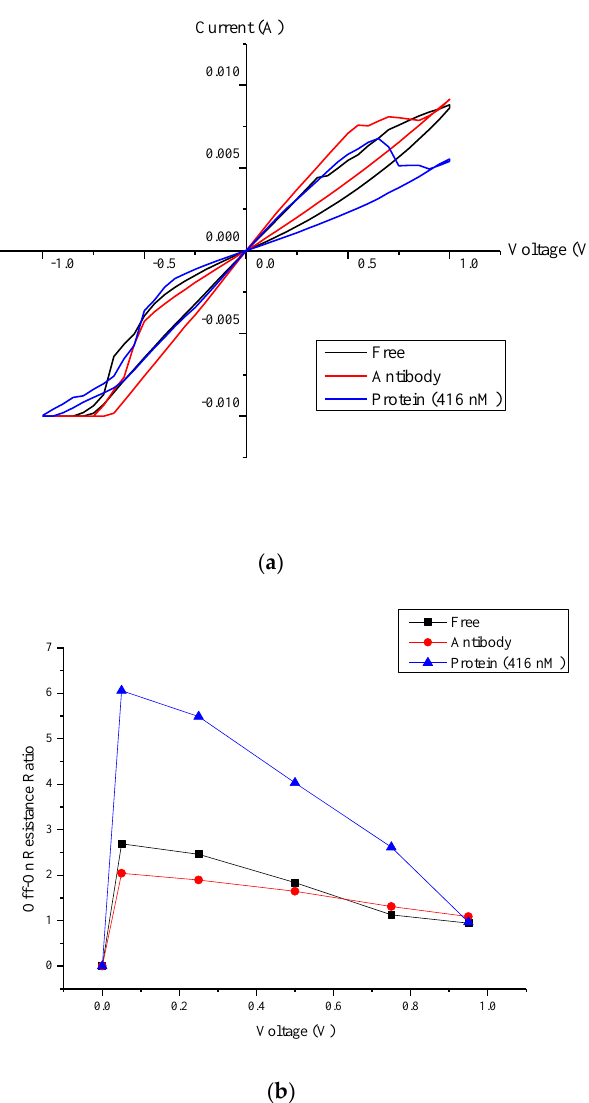
Figure 11. Characterisation plots; ( a ) I-V curve for 2 mm-diameter well; ( b ) Off-On resistance ratio of the memristor at 0 to 1V.